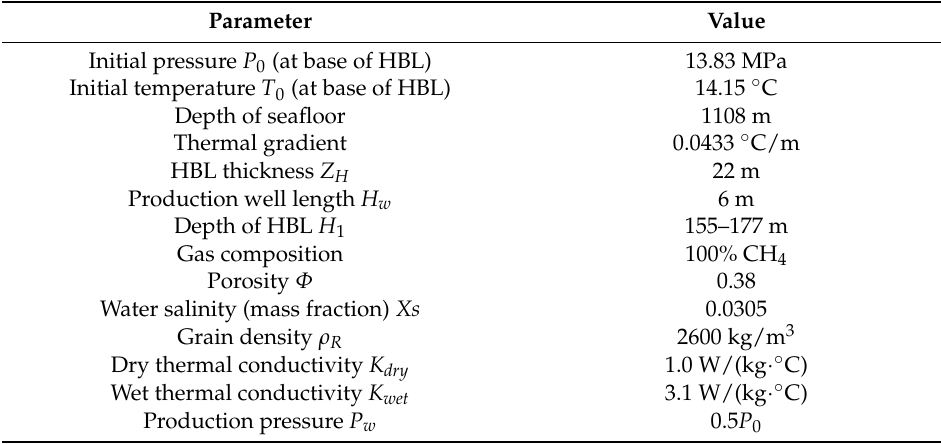
Table 2. Production trial properties and mathematical